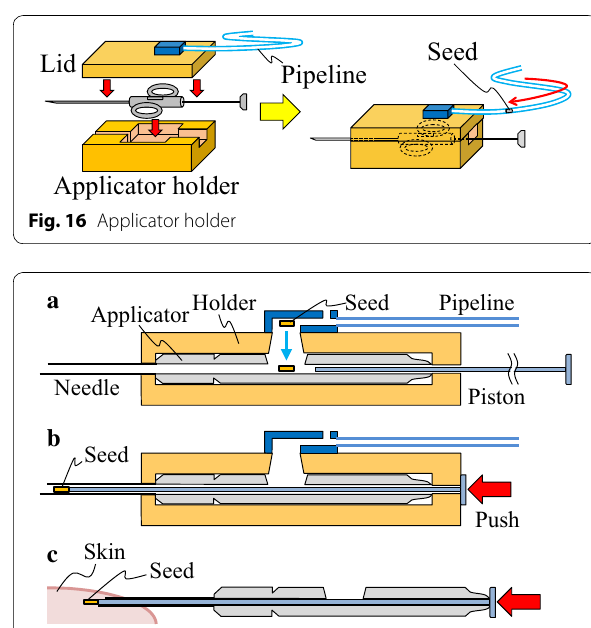
Fig. 17 Mechanism of the applicator holder. a – c Show the motion procedure Fig. 18 Test of the seed-setting